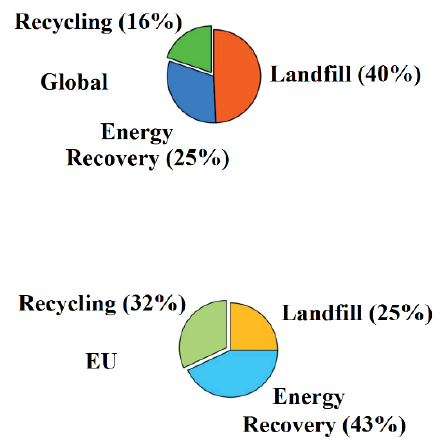
Figure 5. Global and EU waste management rates. Reprinted with permission from ref. [16].